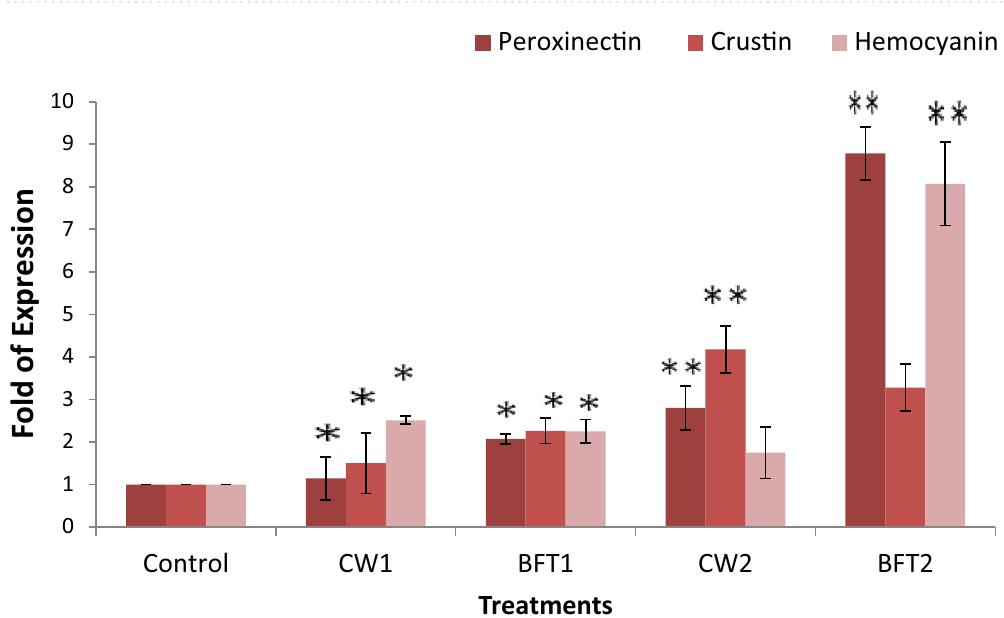
Figure 3. Heatmap representing distribution of top 20 species.